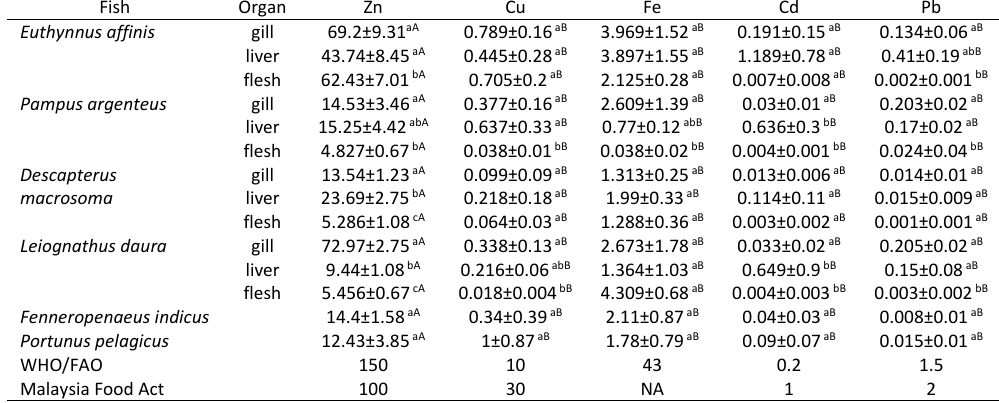
Table 3. Heavy metal concentration (µg/g) found in different selected fish, prawn and crab species